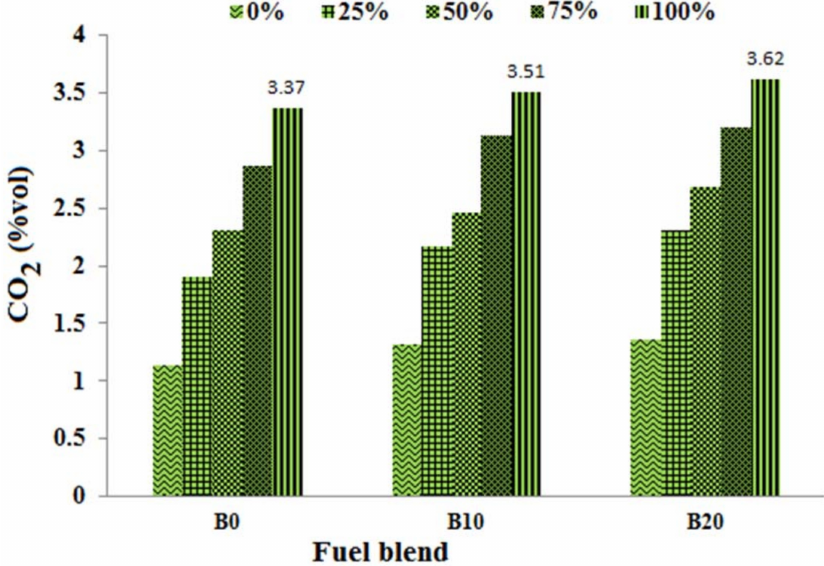
Figure 8. Results of carbon dioxide (CO 2 ) for different fuel blends at the constant speed of 2100 rpm.